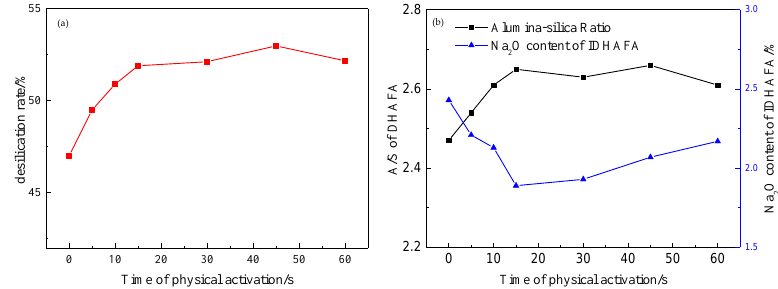
Figure 2. Effect of physical activation time: ( a ) desilication rate, ( b ) A/S and Na 2 O content of IDHAFA. Table 2. Effect of physical activation time on the particle size of HAFA ( µ m).